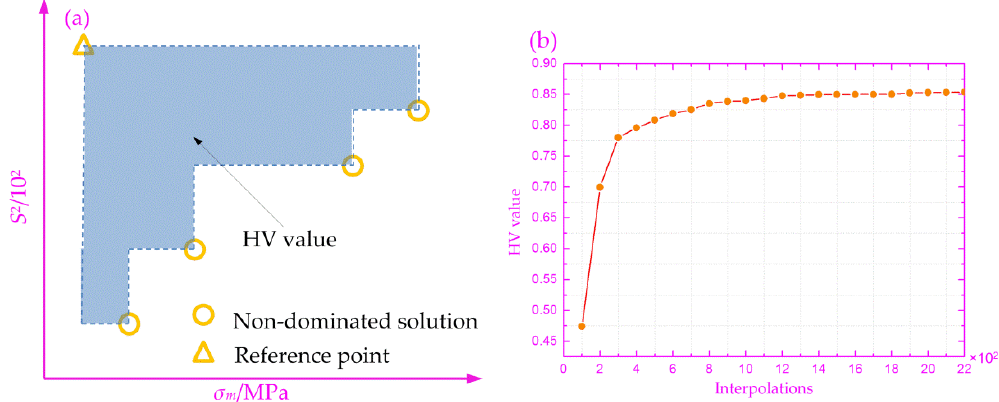
Figure 9. A schematic illustration of the Hypervolume (HV) and its concrete value: ( a ) schematic illustration; and ( b ) tendency of the HV value changes with the increased number of interpolations.